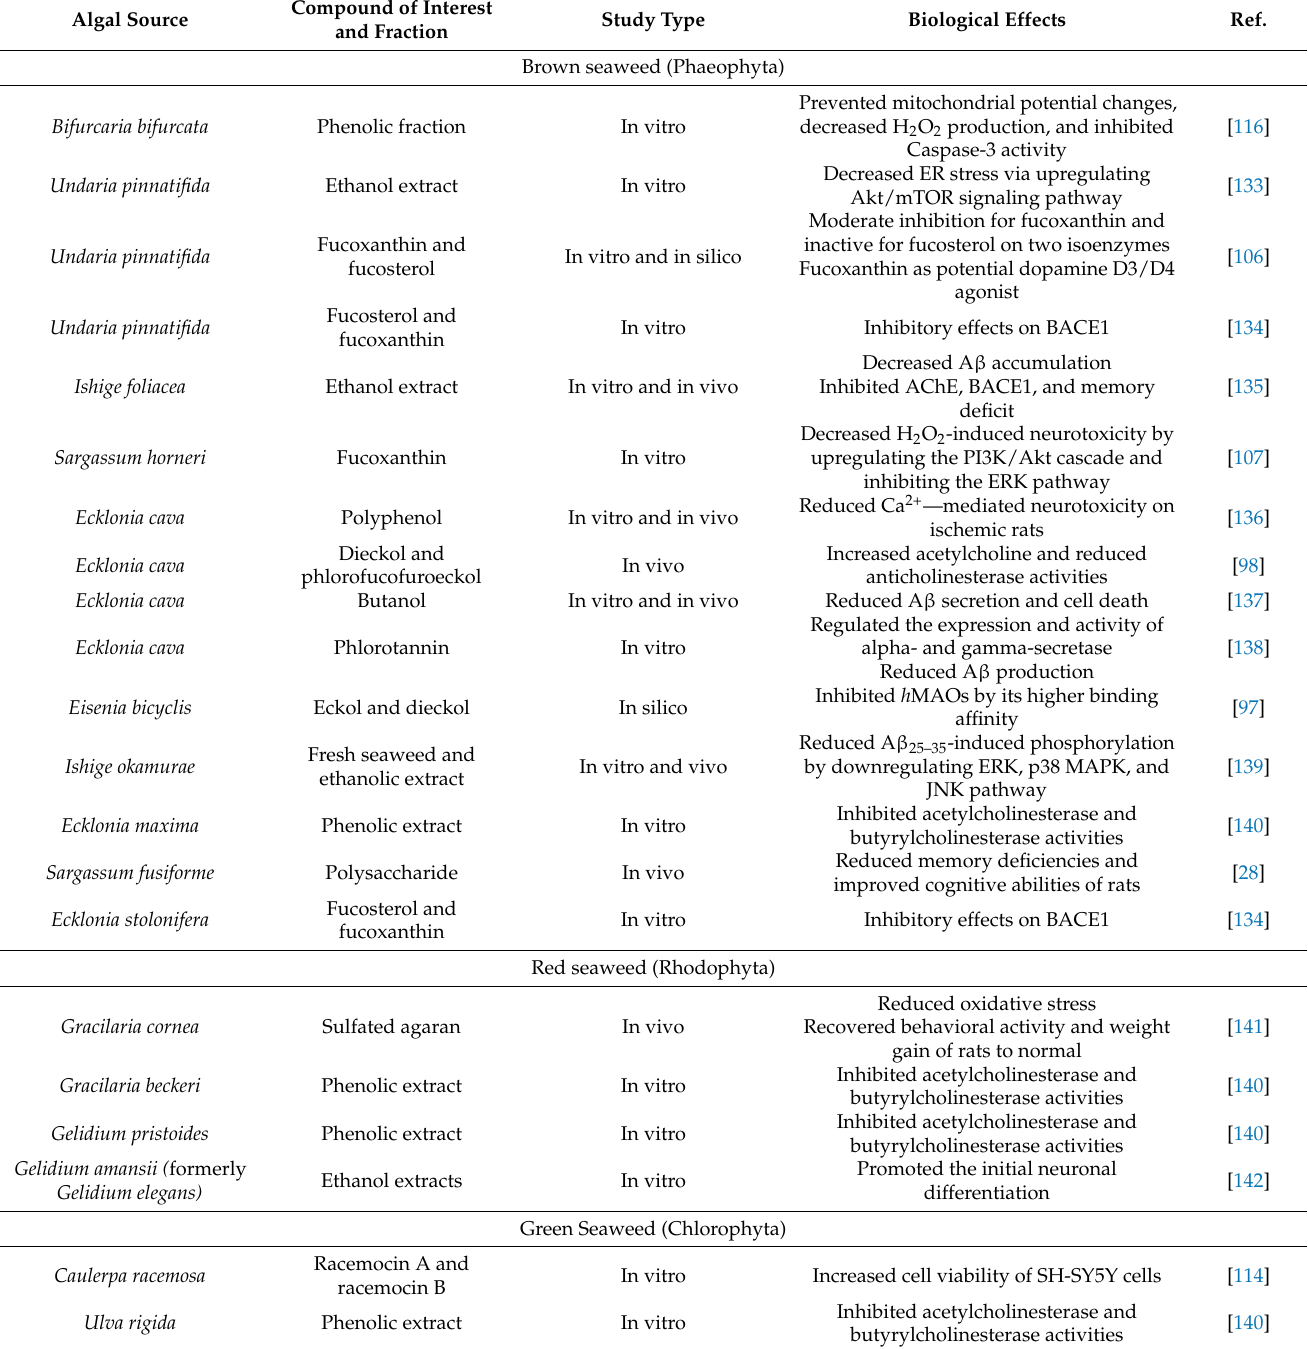
Table 2. The effects of seaweed-derived compounds on neurogenerative